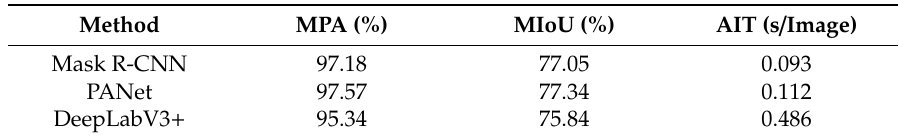
Table 2. Metrics of evaluation results with di ff erent algorithms (mean pixel accuracy (MPA), mean intersection over union (MIoU), and average inference time